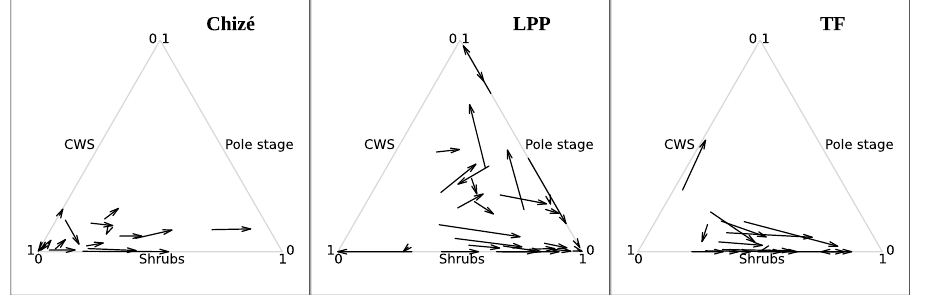
Figure 1. Ternary plots showing the marginality vectors of each female roe deer monitored at Chizé, La Petite Pierre and